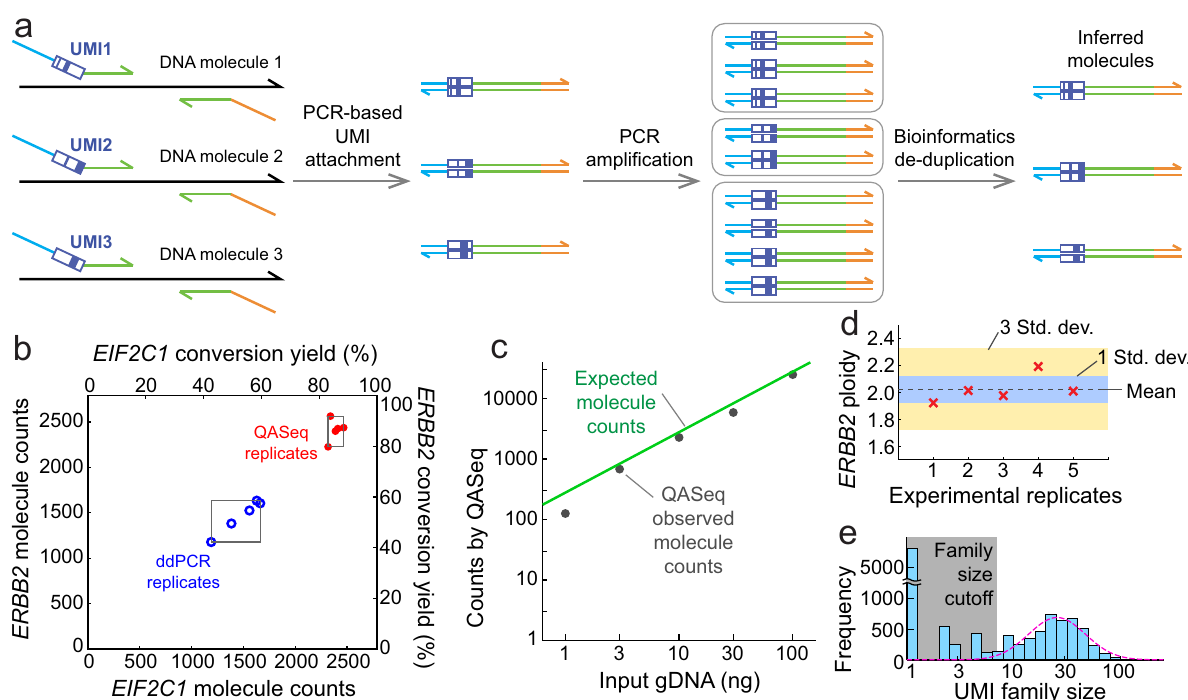
Fig. 1 NGS-based QASeq DNA absolute quantitation modules. a Schematic of a single QASeq module for quantitation of DNA bearing a speci fi c nucleotide sequence. Each input DNA strand was attached with a UMI by 2 PCR cycles. Further PCR ampli fi cation was performed after removing non- extended primers bearing UMI. NGS reads originating from the same input DNA strand carry the same UMI sequence, thus unique UMI family count represents the number of input DNA strands. b Quantitation of ERBB2 and EIF2C1 molecule count using 2-plex QASeq and ddPCR. Five replicated experiments were performed for both methods with 10 ng gDNA input. QASeq showed higher conversion yield (86% on average) than ddPCR (53% on average). The CV of molecule count was lower for QASeq (5.0% for ERBB2 , 2.5% for EIF2C1 ) than for ddPCR (12.8% for ERBB2 , 13.3% for EIF2C1